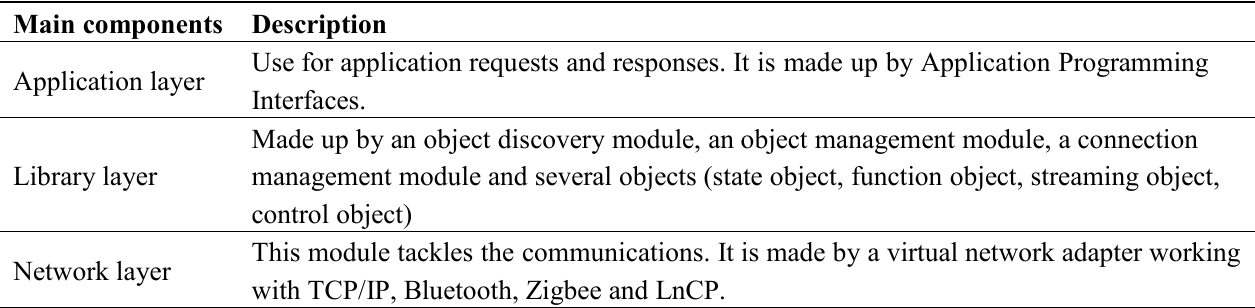
Table 4. Description of OHNet